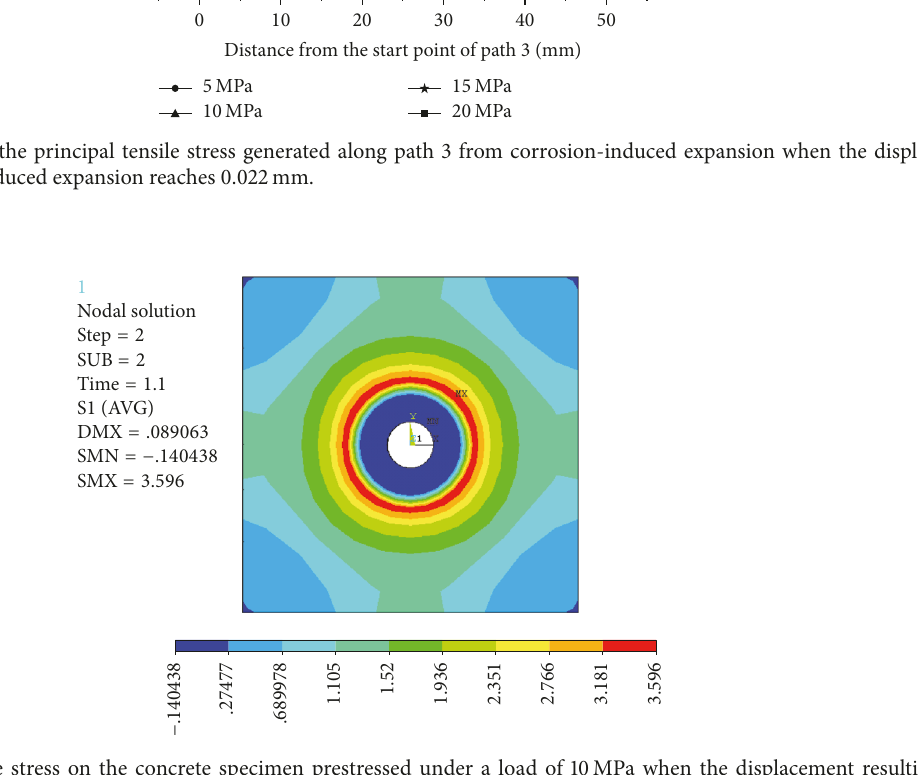
Figure 28: Principal tensile stress on the concrete specimen prestressed under a load of 10MPa when the displacement resulting from corrosion-induced expansion reaches 0.005